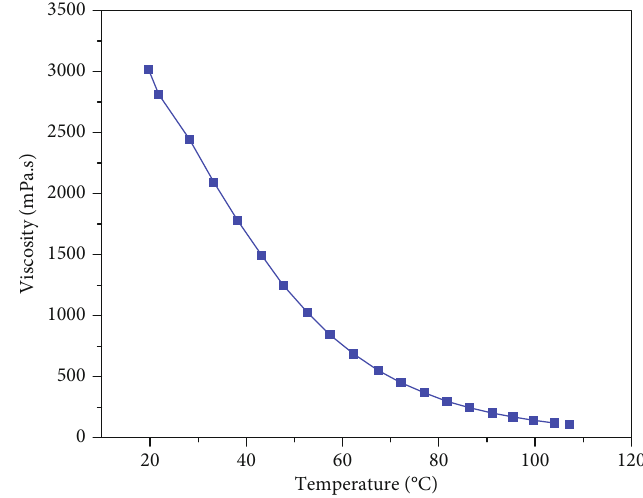
Figure 1: Relationship between viscosity and temperature of experimental oil.